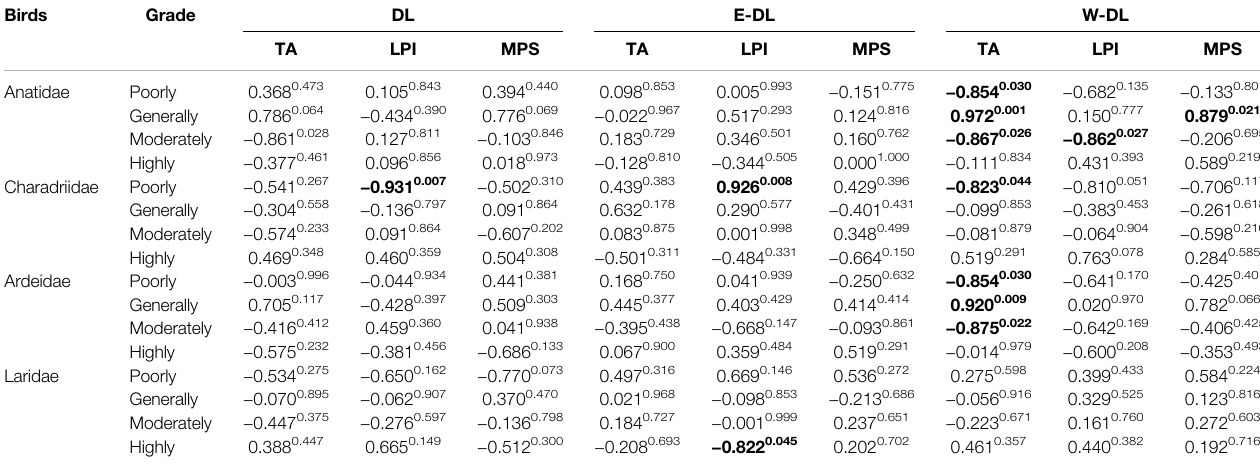
TABLE 3 | Correlation Coef fi cient between Each Index of the DL (E-DL, W-DL) and their poplar area. The signi fi cance of the correlation is shown by superscript and the signi fi cant correlation coef fi cients are shown in bold. The information of HL and S-DL about this is showing in Supplementary Table S3 .